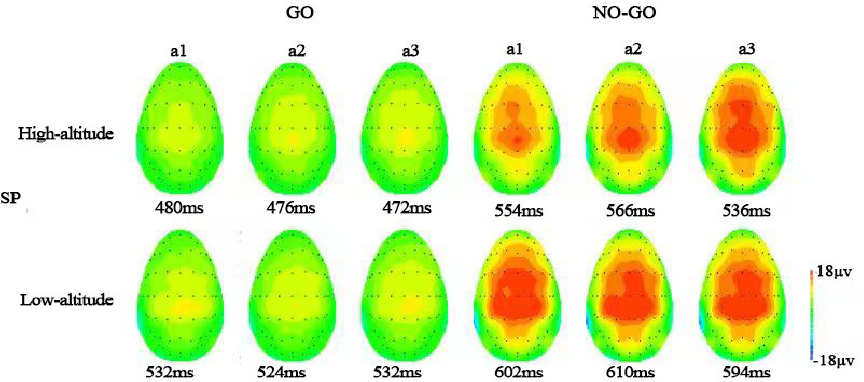
Figure 4. The images represent activity on the scalp at the time corresponding to the maximum amplitude of each component for each group.